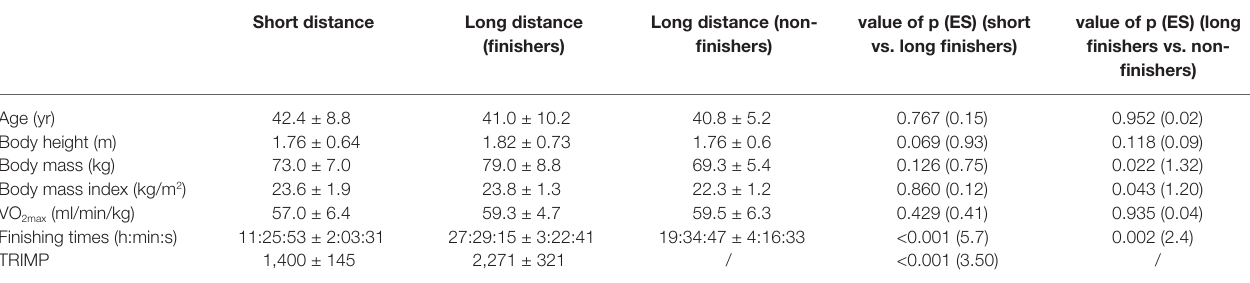
TABLE 1 | Baseline characteristics of the participants and TRIMP during the competitions shown as mean ± SD. Short